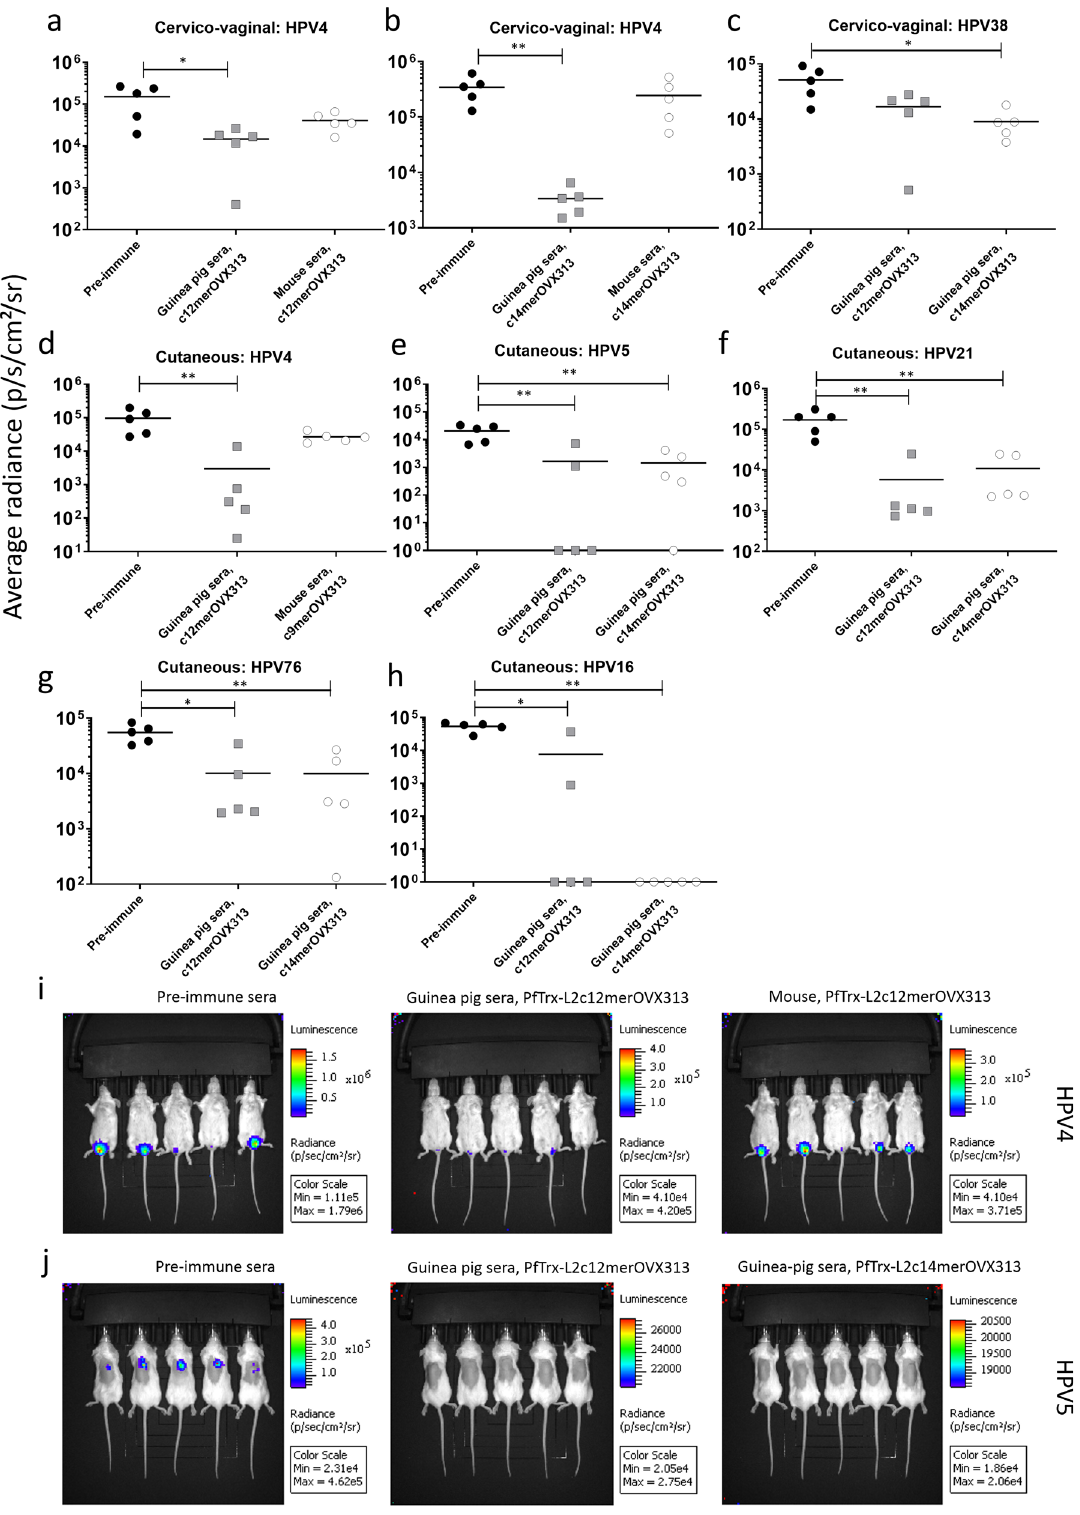
Fig. 8 Sera raised against the leading candidate vaccines passively protect naïve mice against HPV PSV challenge. Pools of sera derived from either 10 mice, or 2 guinea pigs immunized with PfTrx-L2c9merOVX313 (20µg), PfTrx-L2c12merOVX313 (30µg) or PfTrx-L2c14merOVX313 (30µg) were passively transferred to naive mice. Protection against cervico-vaginal ( a – c ) or cutaneous challenge ( d – h ) with the indicated cutaneous HPV PSV types was compared to passive immunization with sera from non-immunized mice ( pre-immune ). The y -axis represents the average radiance measured as photons per second per square centimeter per steradian. Note that different scales were employed in order to take into account the different in vivo transduction ef fi ciencies of individual HPV PSV types. A P -value of ≤ 0.05 was considered signi fi cant. * P <0.05; ** P <0.01; *** P <0.001, as determined by the nonparametric Mann – Whitney test. Representative images of the passive transfer of immune sera followed by cervico-vaginal ( i ) or cutaneous challenge ( j ) with the indicated cutaneous HPV PSV types. Colors (scale shown on the right) represent the intensity of luciferase expression upon transduction and challenge with the indicated PSVs as average radiance (photons per second per square centimeter per steradian). Published in partnership with the Sealy Institute for Vaccine Sciences npj Vaccines (2022)